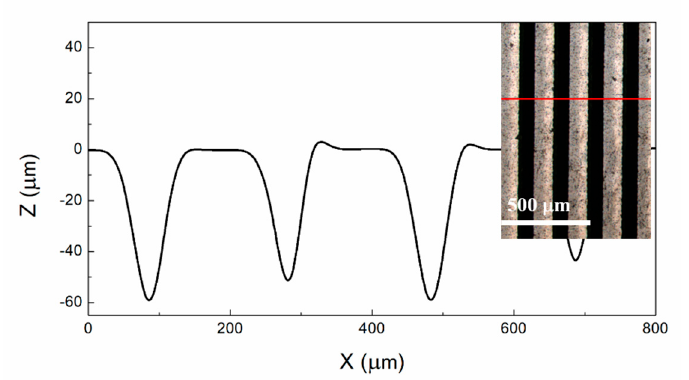
Figure 4. Depth of laser-ablated grooves of sample B.